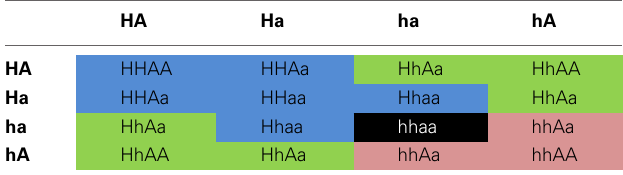
Table 1 | Punnett square of the selfing cross of the ABI3:HCC1 -complemented hemizygous hcc1